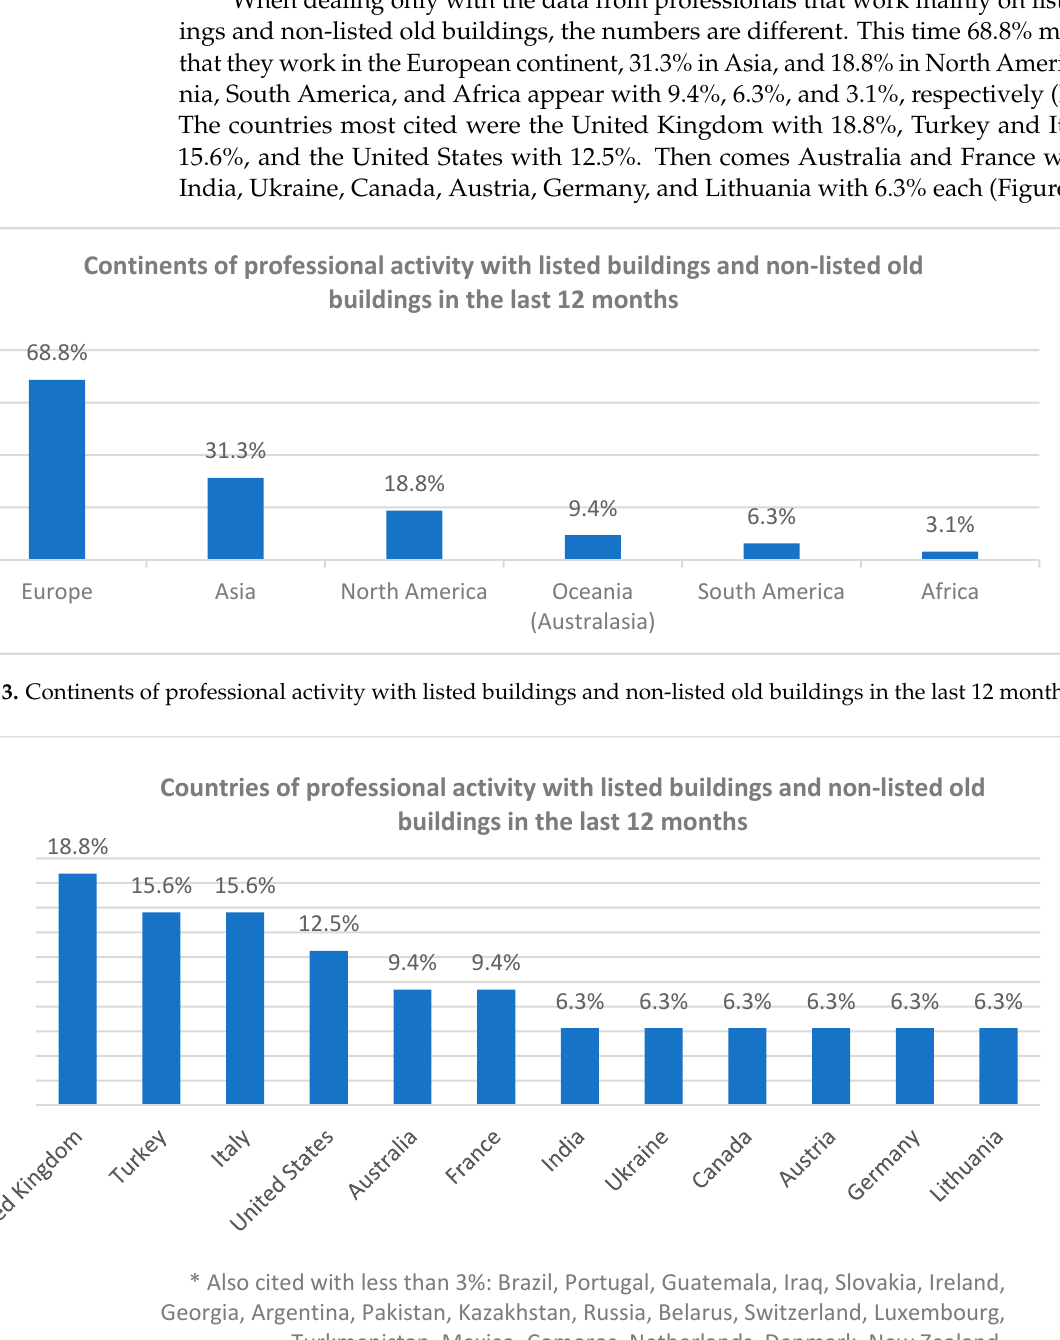
ISPRS Int. J. Geo-Inf. 2021 , 10 , x FOR PEER REVIEW